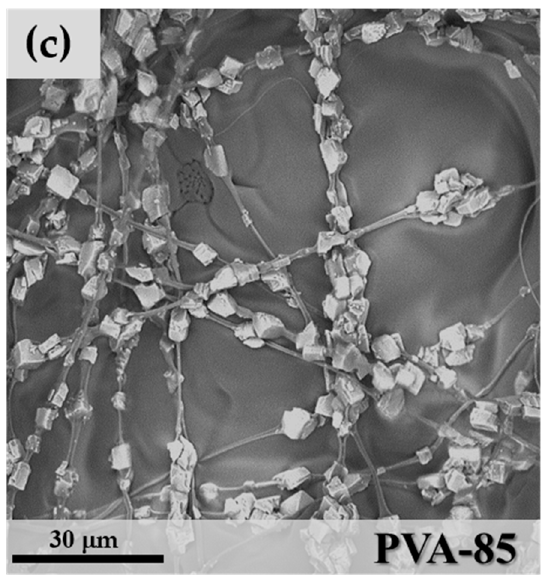
Figure 7. SEM images of ( a ) PVA-60; ( b ) PVA-80 and ( c ) PVA-85.